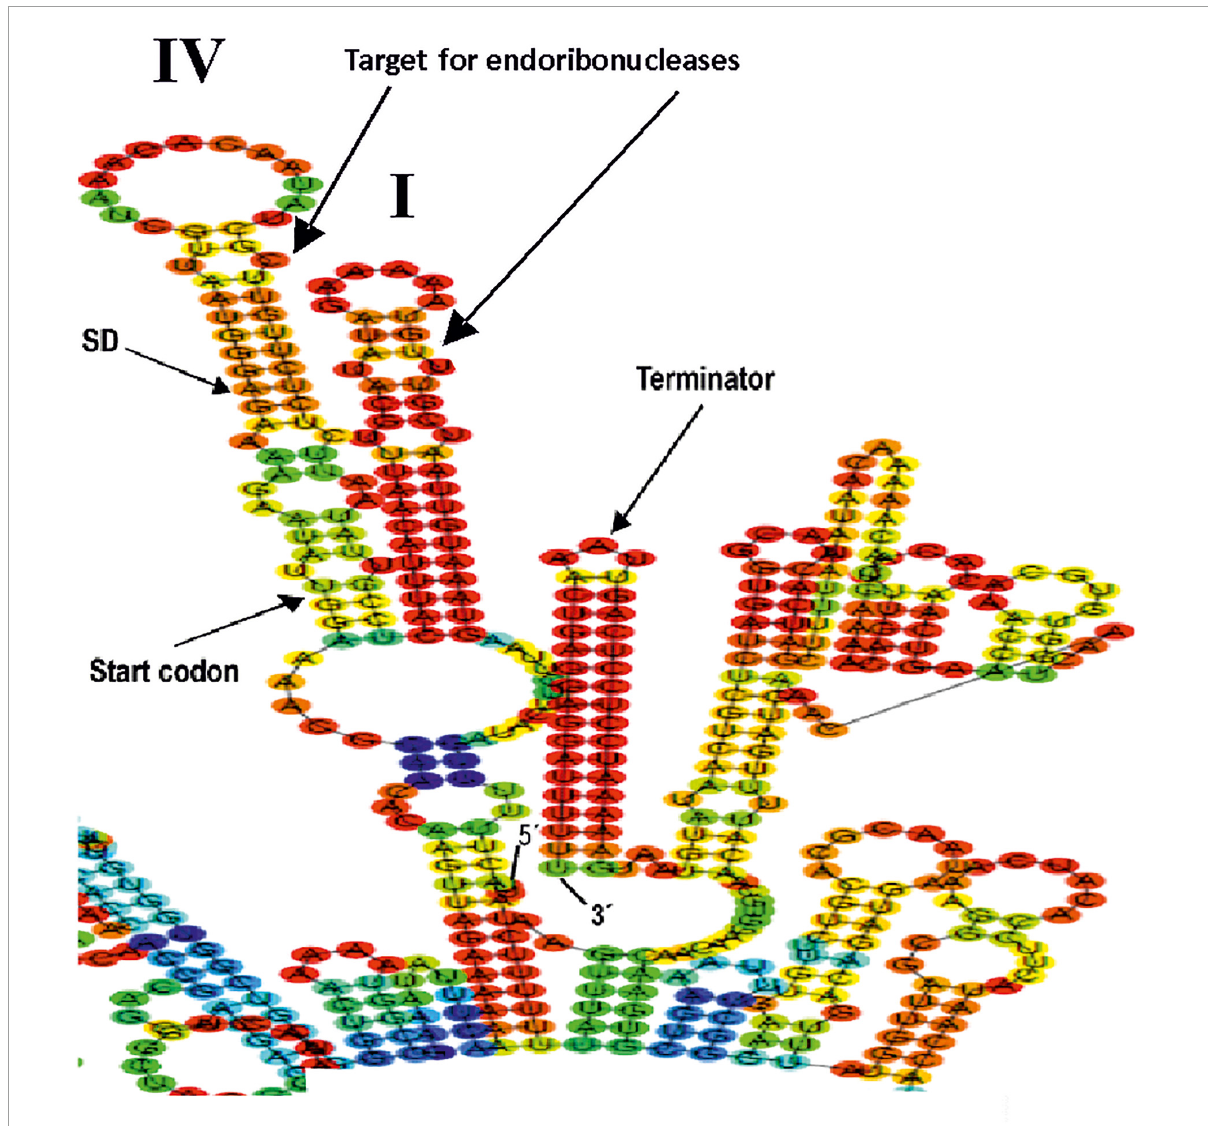
FIGURE6 Details of predictive folding of the dsrLL transcript driven from P dsrLL promoter encoded by in Lc. lactis AV1n[pRCR21] chromosome. The 5 (cid:48) - and 3 (cid:48) -ends of the mRNA are indicated. The sequences of the secondary structures I and IV, ribosomal binding site (SD), dsrLL translation initiation codon (start codon), and Rho-independent terminator are shown in